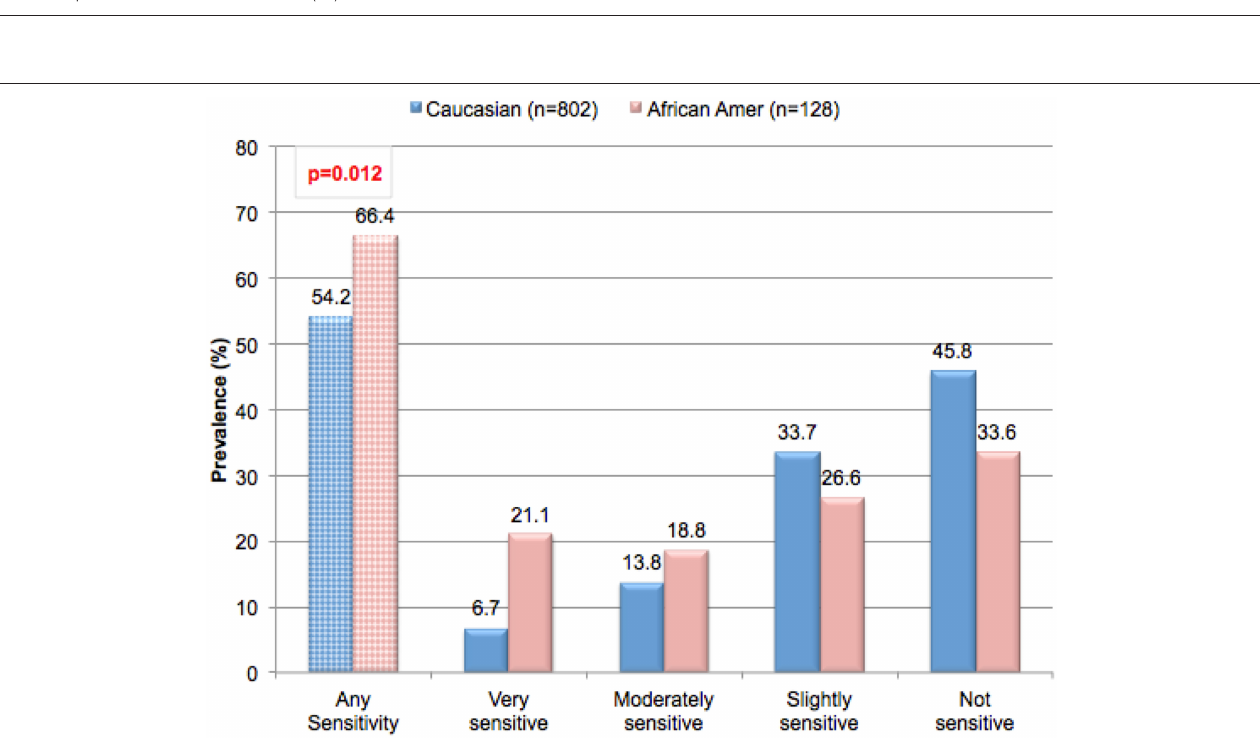
FIGURE 2 | Prevalence of perceived sensitive genital skin among ethnic groups. Subjects in the metropolitan area of Cincinnati, Ohio were asked to complete a sensitive skin questionnaire. Participants were asked to describe their skin sensitivity as very, moderately, slightly or not sensitive. Subsequently, participants were asked to describe the skin of specific anatomic sites including the genital area using the same four-point scale. The percentage of participants claiming any degree of skin sensitivity, and the percentage giving each degree of response (i.e., very, moderately, or slightly) are plotted. Results for ethic groups were compared using a Mantel-Haenszel Chi-Square analysis. [Data adapted from Farage (16)].